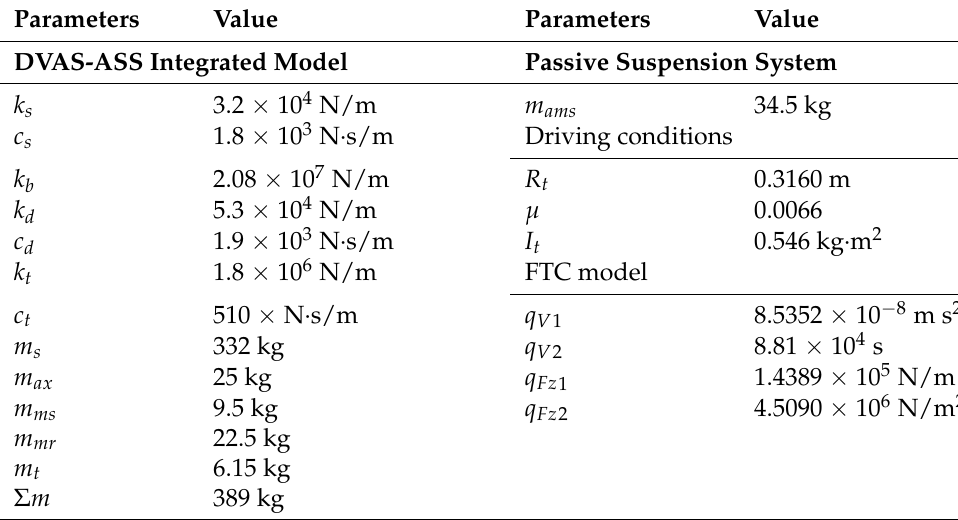
Table 1. Test vehicle